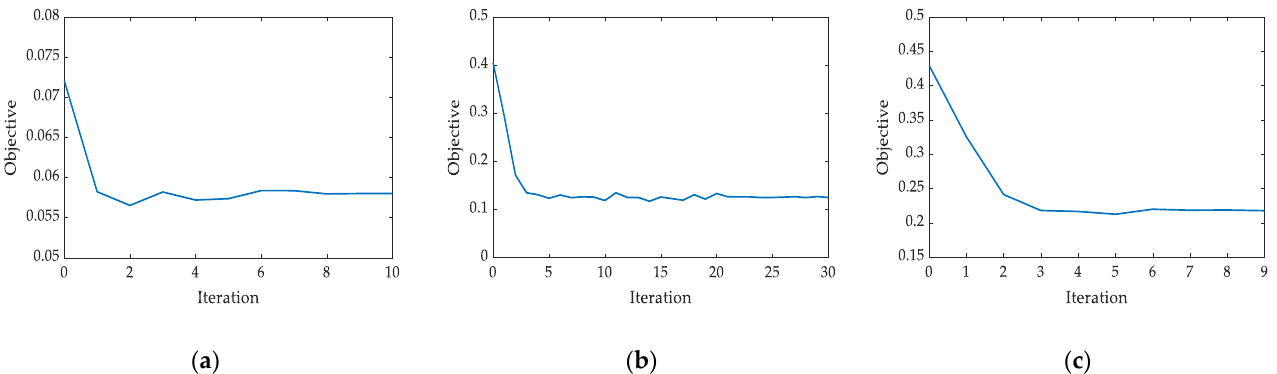
Figure 12. The process of optimization iteration: ( a ) optimization scheme A; ( b ) optimization scheme B; ( c ) optimization scheme C.